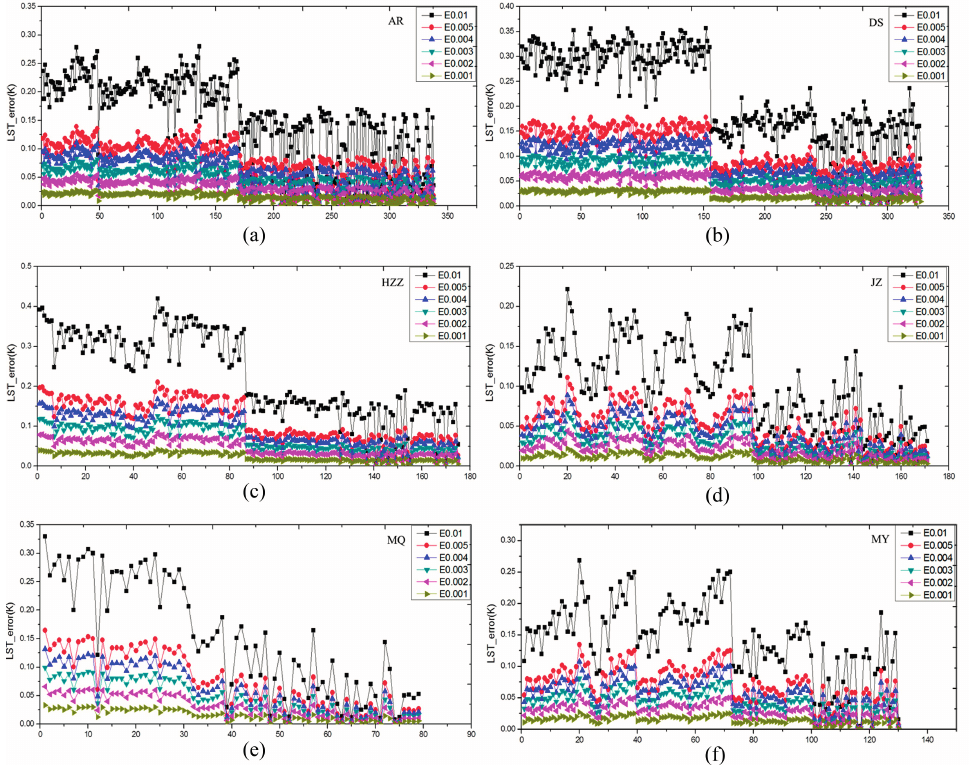
Figure 6. Results of the sensitivity analyses of the broadband emissivities for each station. The y -axis indicates the Δ T S in Equation (8). The x-axis indicates the sequence numbers of longwave radiation data used to evaluate the MODIS LSTs during the daytime or nighttime. ( a ) AR station; ( b ) DS station; ( c ) HZZ station; ( d ) JZ station; ( e ) MQ station; ( f ) MY station; ( g ) NM station; ( h ) SPT station; ( i ) TYF station; ( j ) YK station; ( k ) TYG station; ( l ) YZ